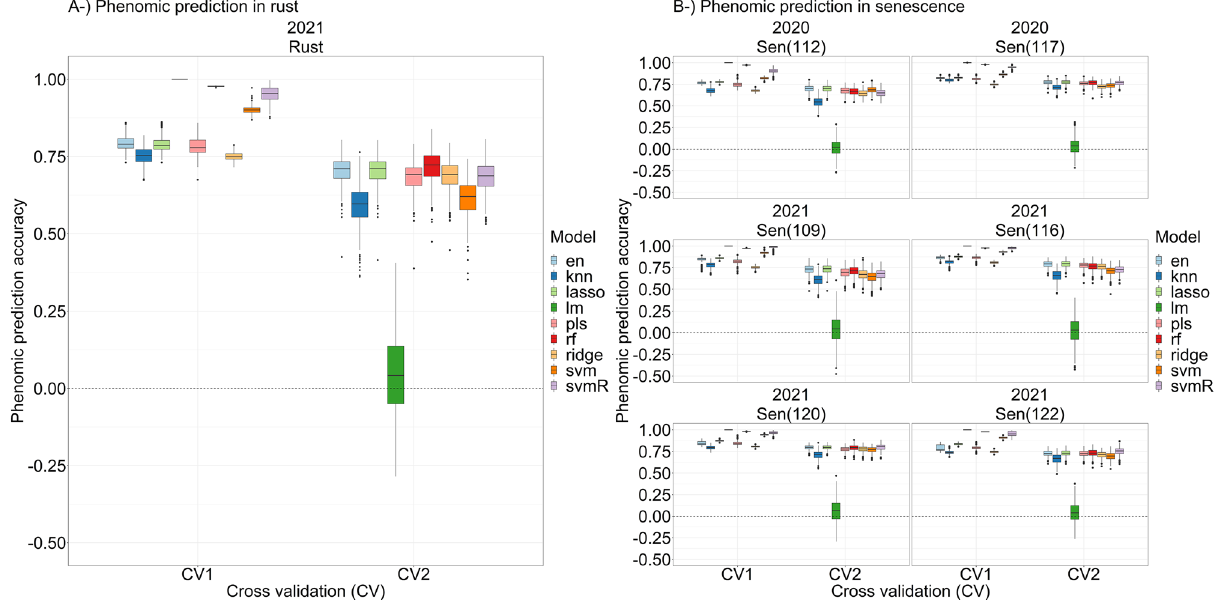
Figure 9. Phenomic prediction abilities of eight machine learning algorithms for ( A ) rust, and ( B ) two and four different senescence scores in 2020 and 2021. Y axes in both ( A ) and ( B ) represent phenomic prediction accuracy; X axes correspond to cross validation where phenomic prediction accuracy was calculated over training data (CV1), and test data (CV2). In all cases, linear model (lm) displayed lowest prediction